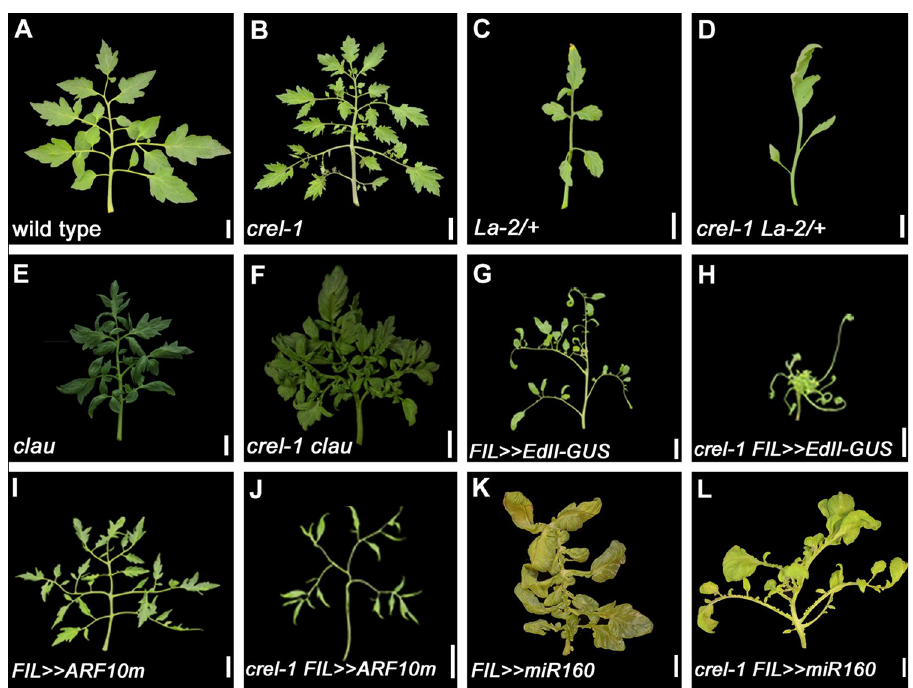
Fig 2. CREL acts relatively late in leaf development to promote differentiation and blade growth. (A-F, I, J) Mature 5 th leaves. (K,L) Mature 9 th leaves. (G, H) whole plants. Scale bars: 2cm. FIL >> gene refers to genotypes generated by the LhG4-OP transactivation system, where the gene is expressed in the FIL expression domain. The FIL promoter is expressed in leaf primordia [52]; EdII-GUS is a stabilized form of E fused to the GUS reporter; ARF10m is a mutant form of ARF10 that is mutated in the miR160 binding site. A-D—epistasis of La-2/+ , in which differentiation is accelerated, over crel . E, F—enhancment of crel by clau , in which differentiation is delayed. G-J–enhancment of genotypes with narrow leaves due to reduced auxin response by crel . K, L–suppression of the ectopic blade growth of FIL >> miR160 by crel , similar to the effect on e